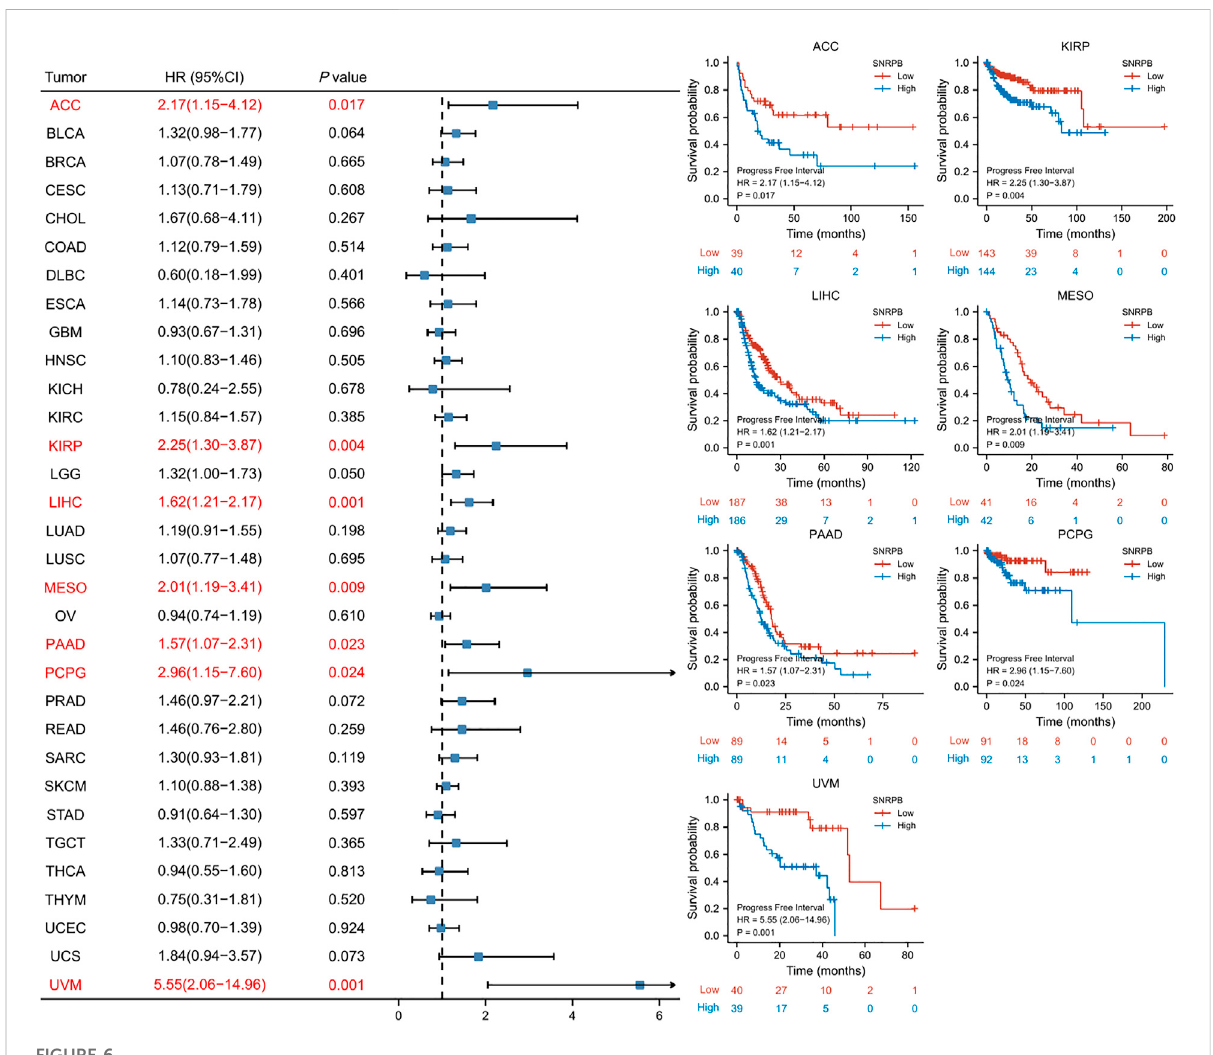
FIGURE 6 The relationship between SNRPB expression and PFI across